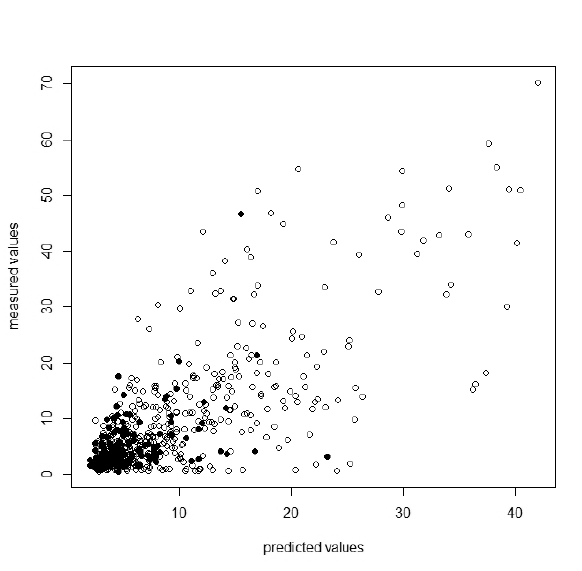
Figure 3: Predicted ST6 super position (x-axis) vs. measured values (y-axis) in the test set. A product group with inferior performance is highlighted (black).